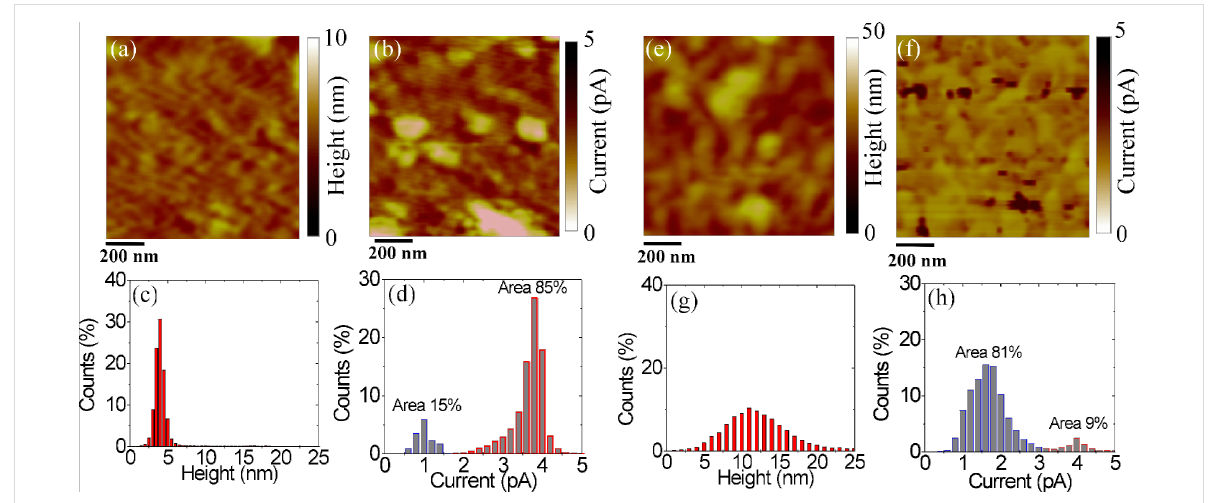
Figure 6: TRCAFM of Graphene on SiO 2 : (a) morphology and (c) the related histogram, (b) current map and (d) the related histogram. TRCAFM of Graphene on PEN: (a) morphology and (c) the related histogram, (b) current map and (d) the related histogram.